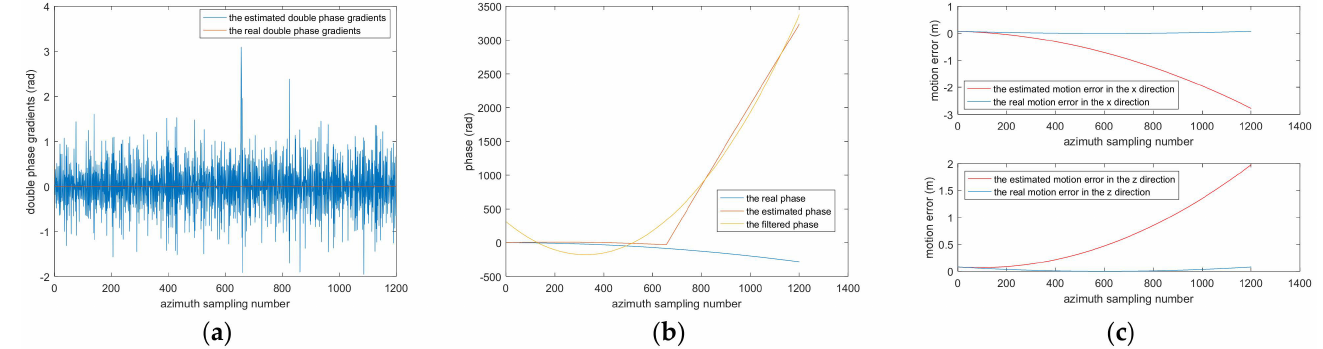
Figure 9. ( a ) Double phase gradient estimation result; ( b ) Phase comparison after double integration; ( c ) Motion error estimation results when the step length defaults to 1 (simulation